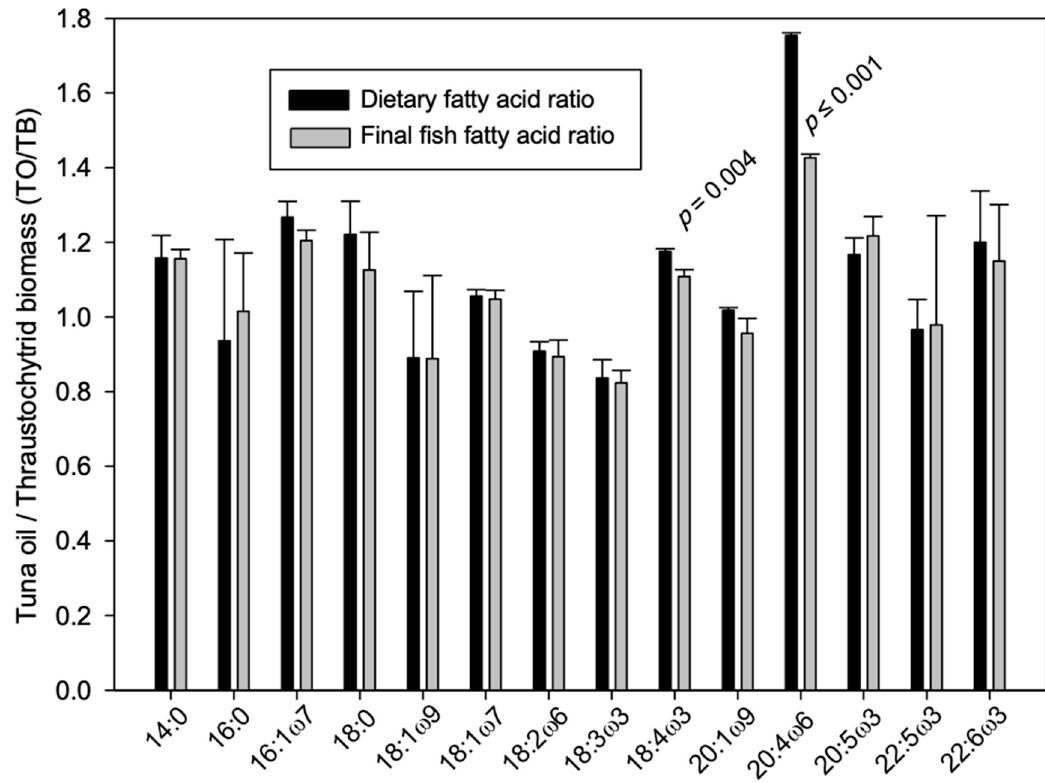
Figure 2. Ratios of individual major fatty acids, calculated as tuna oil (TO) control / thraustochytrid biomass (TB) tests, in the diets and the salmon fingerlings at the end of the 70 day feeding period. The error bars indicate the standard deviation, and there were no significant differences in the ratios, except for 18:4 ω 3 ( p = 0.004) and 20:4 ω 6 ( p ≤ 0.001).